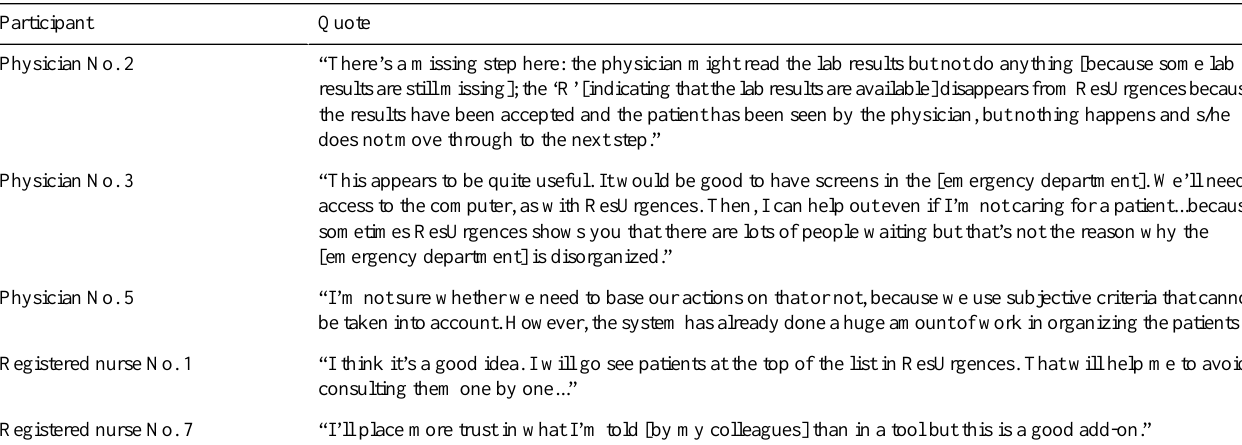
Table 4. Quotes from registered nurses and physicians during phases 3 and 4 of the user